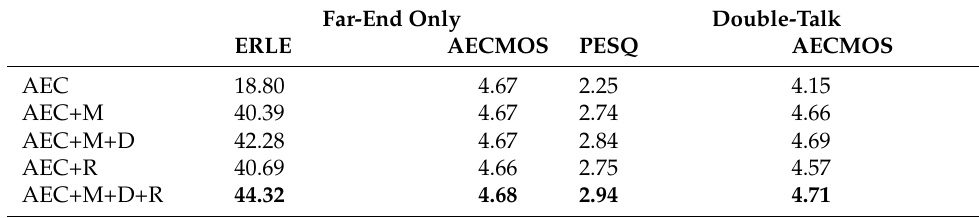
Table 1. Ablation study results. M stands for masking, D for DTD, and R for refinement. Far-End